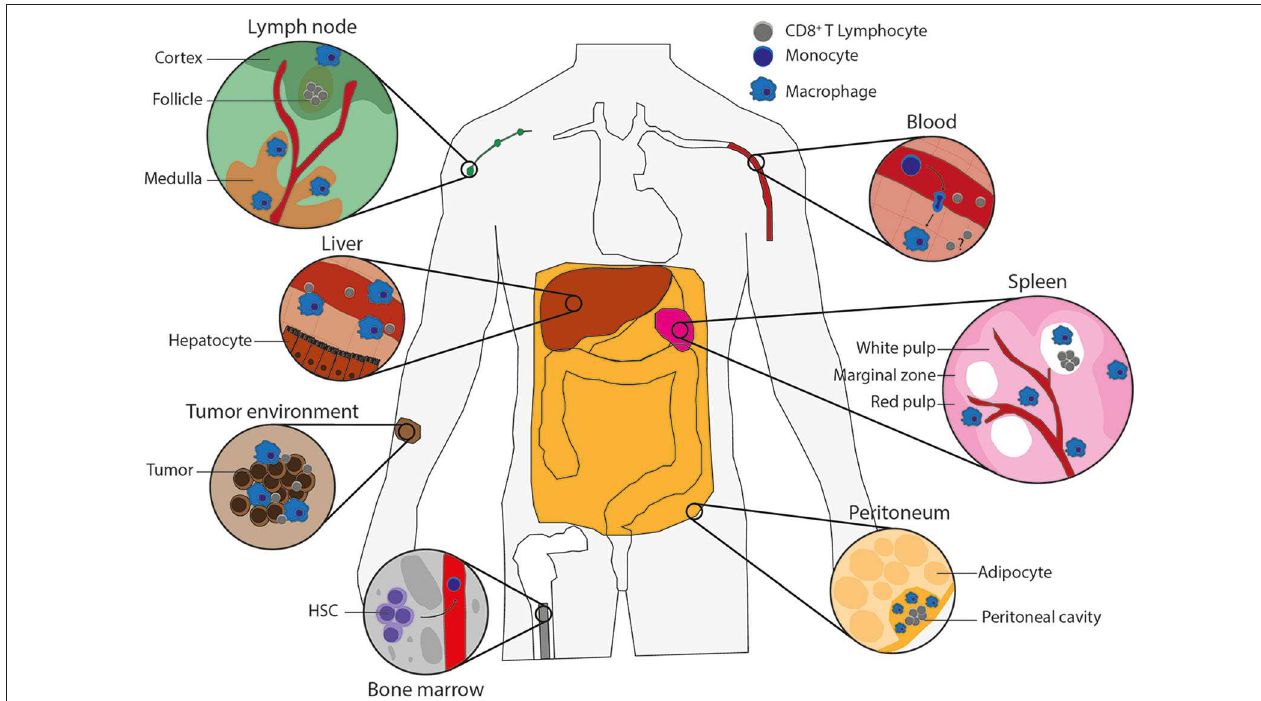
FIGURE 1 | Macrophage types potentially capable of antigen cross-presentation. Populations of macrophages in various tissues of the body that can cross-present antigen and their potential interactions with CD8 + T lymphocytes. Lymph node: blood vessel (red), cortex and follicle (green) with CD8+ T lymphocytes (gray) in the T-cell zone and subcapsular macrophages on the edge (blue), medulla (brown) including medullary sinus macrophages, medullary cord macrophages and subcapsular macrophages (blue). Liver: blood vessel (red) containing CD8 + T lymphocytes (gray) and Kupffer cells (blue) on the edge, which are surrounded by hepatocytes. Tumor environment: tumor-infiltrating macrophages (blue) and CD8 + T lymphocytes (gray) in between tumor cells (brown). Bone marrow: hematopoietic stem cells (HSCs), which give rise to monocytes (dark blue) that leave the bone marrow by blood vessels (red). Blood: monocytes in the blood vessels (red) can extravagate through the vessel wall into tissues, where monocytes (dark blue) differentiate into macrophages (blue), and there could be memory T cells (gray) to reactivate upon infection. Spleen: the spleen consists of red pulp (pink), white pulp (soft pink) with follicles (white) containing CD8 + T lymphocytes (gray), and blood vessels (red). The red and white pulps are separated by the marginal zone. All contains macrophages (blue), including the marginal zone, which contains marginal metallophilic and marginal zone macrophages. Peritoneum: the adipocytes (soft yellow) surround the peritoneal cavity (yellow), which includes large and small peritoneal macrophages (blue) and CD8 + T lymphocytes